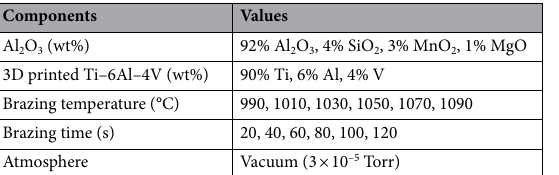
Table 2. Joint materials and brazing